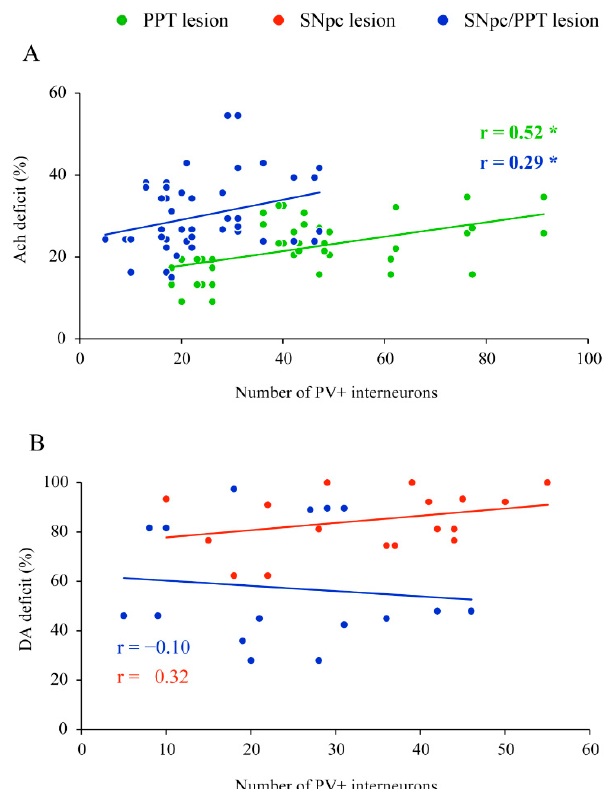
Figure 3. Functional coupling between the altered number of PV+ interneurons within DG and the PPT cholinergic or SNpc dopaminergic deficits in the distinct rat models of PD neuropathology. ( A ) The significant positive correlation between the number of PV+ interneurons in DG and the PPT cholinergic (Ach) deficit in the rats with PD cholinopathy (PPT lesion; n = 4) and hemiparkinsonian rats with PD cholinopathy (SNpc/PPT lesion; n = 6); ( B ) No significant correlation between the number of PV+ interneurons in DG and SNpc dopaminergic (DA) deficit in the hemiparkinsonian rats (SNpc lesion; n = 4) and hemiparkinsonian rats with PD cholinopathy (SNpc/PPT lesion; n = 7). Bold numbers with * indicate the statistically significant correlations at p ≤ 0.05.